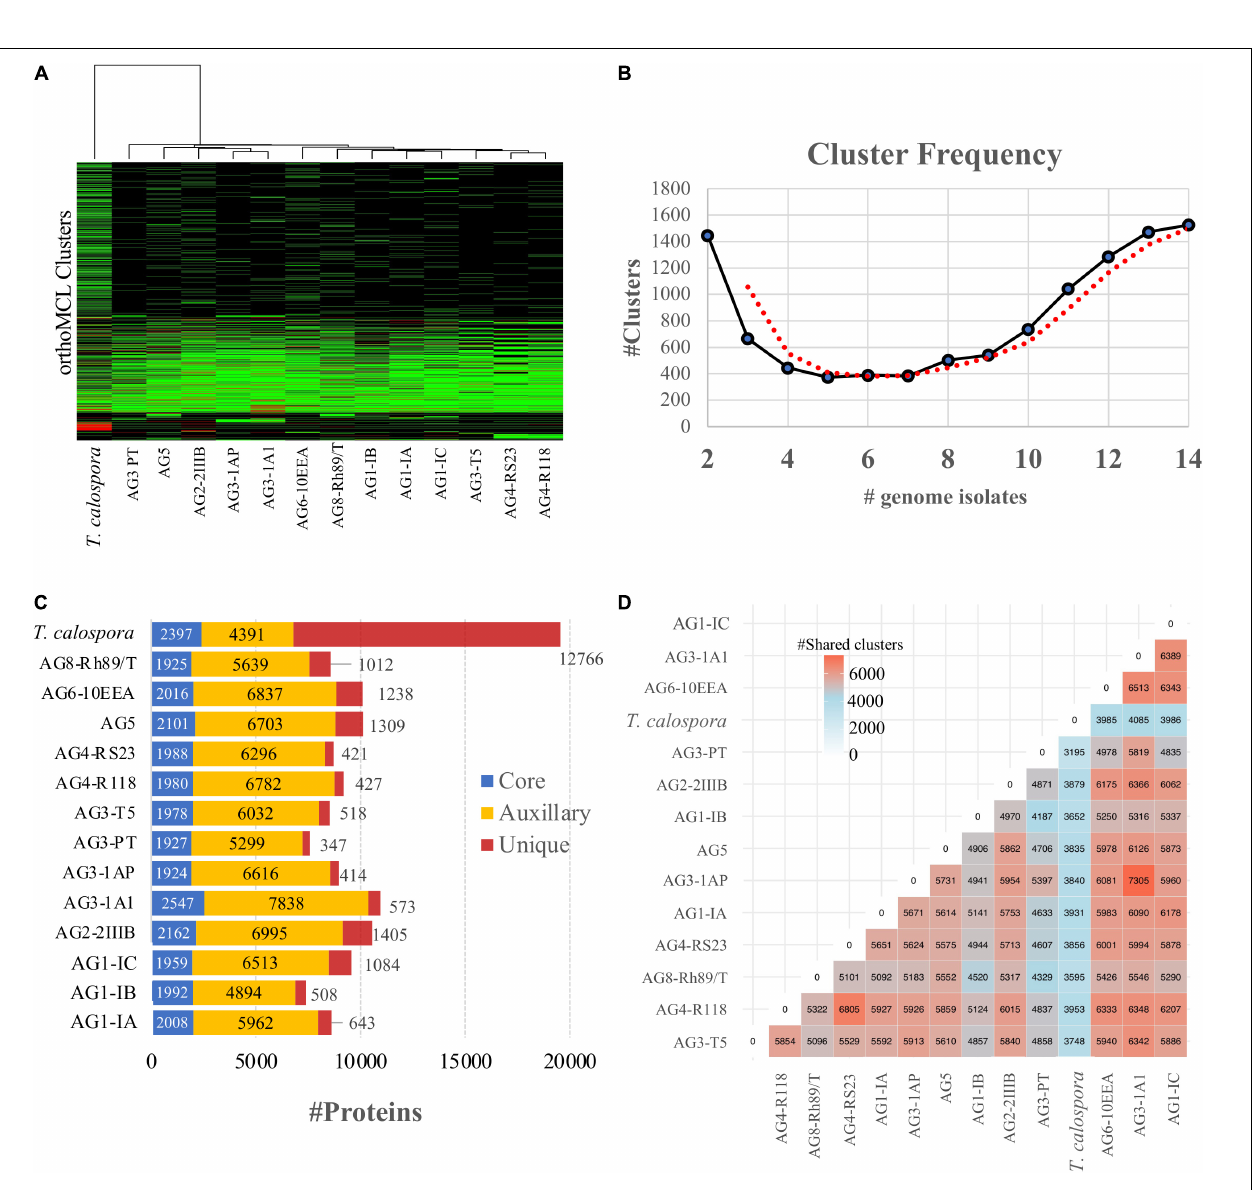
FIGURE 2 | OrthoMCL clustering of the predicted proteomes in R. solani AGs. (A) Heatmap showing protein conservation across all sequenced R. solani AGs and T. calospora . Each row represents one orthoMCL cluster, and color is proportional to the number of protein members shared within a given cluster from the given species (black: no member protein present; red: large number of protein members present). The hierarchical clustering (hclust; method: complete) analysis enumerates the similarities between different fungal isolates based on proteins shared by them across all orthoMCL clusters. (B) Cluster frequency. The line plot represents the number of orthoMCL clusters shared by different fungal isolates used in this study. Example, > 1,400 orthoMCL clusters are shared by 14 different fungal isolates (including positive and negative controls) used in this study. The bimodal nature of the plot represents high similarities across independent proteomes as large numbers of clusters share protein members from 13 fungal isolates. The red line represents the smoothed curves after averaging out the number of clusters. (C) Protein classification based on the orthoMCL clusters. The “core” proteins represent the sub-set of proteomes (from each R. solani AG and T. calospsora ) with a conserved profile across all the isolates. Similarly, the “unique” sets represent the isolate-specific protein subset. The rest of the protein subsets make up the “Auxiliary” proteome which are conserved in a limited number of isolates. (D) Shared orthoMCL clusters. The number of orthoMCL clusters shared between any two isolates. A shared cluster means, a given orthoMCL cluster contains proteins from both the isolates.